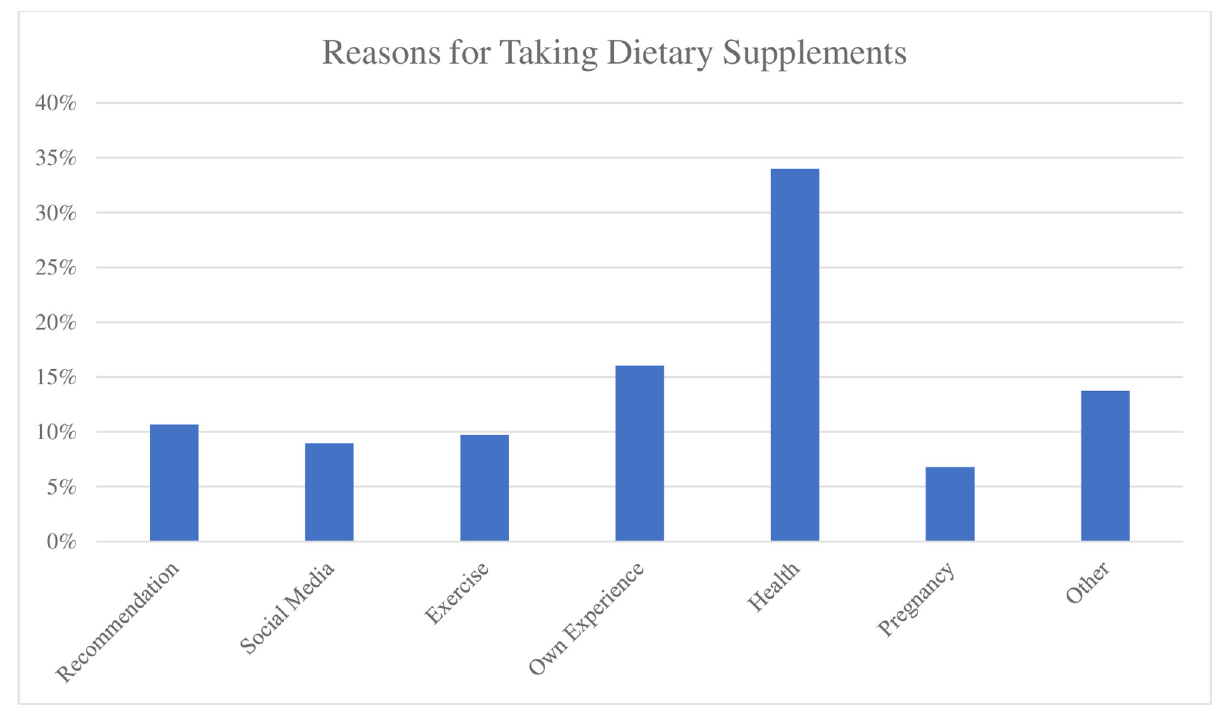
Fig 2. The participants’ reasons for using dietary supplements (n = 275).